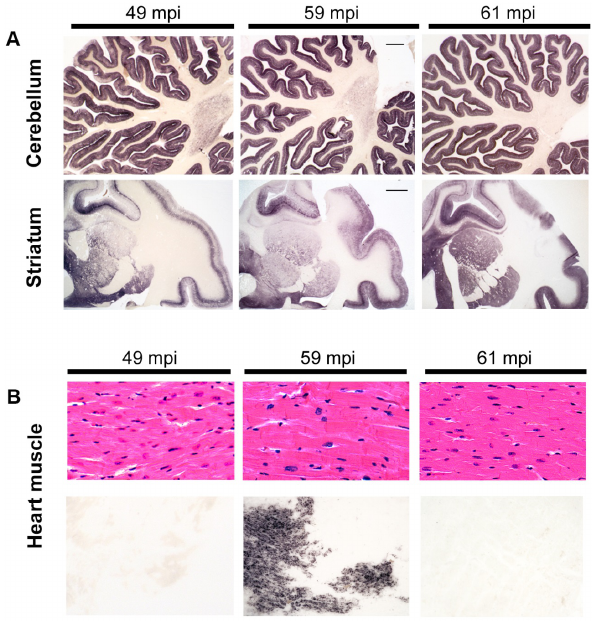
Figure 1. Tissue samples form three rhesus monkeys (49 mpi; 59 mpi; 61 mpi) infected with BSE prions and with clinical symptoms were analyzed with the monoclonal antibody (mab) 12F10. (a) Samples from brain (cerebellum and striatum). (b) Sam- ples from heart muscle. With modifications from Krasemann et al.